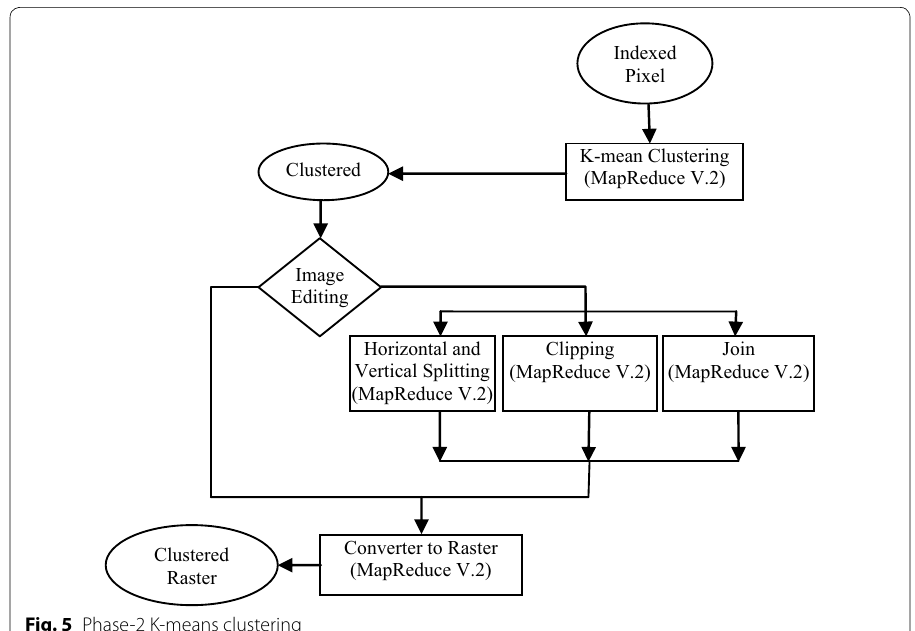
Fig. 5 Phase-2 K-means